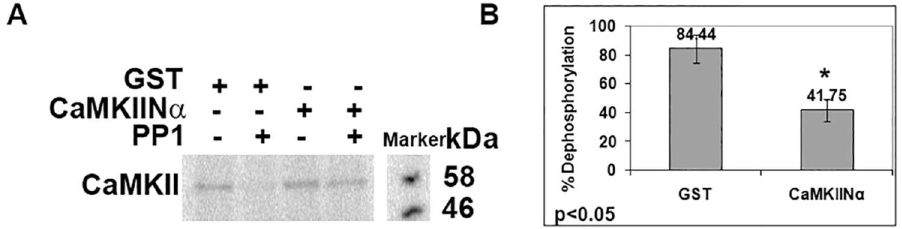
Fig 2. CaMKIIN α inhibitsthe dephosphorylationof CaMKII. A: AutophosphorylatedCaMKIIwas dephosphorylatedin presence of eitherGST as controlor GST-CaMKIIN α .The same dephosphorylation condition was appliedto all samplesbut, with and withouttreatmentof PP1. B: Difference between the densitometricvalues of autoradiographic bands obtainedwith and withoutPP1 was used for calculating dephosphorylation.The values plottedare the mean ± standarddeviation of data of four experiments. In each set, the intensityof the band withoutPP1 treatmentwas taken as 100% phosphorylation (p < 0.05 in two- tailedstudent’s